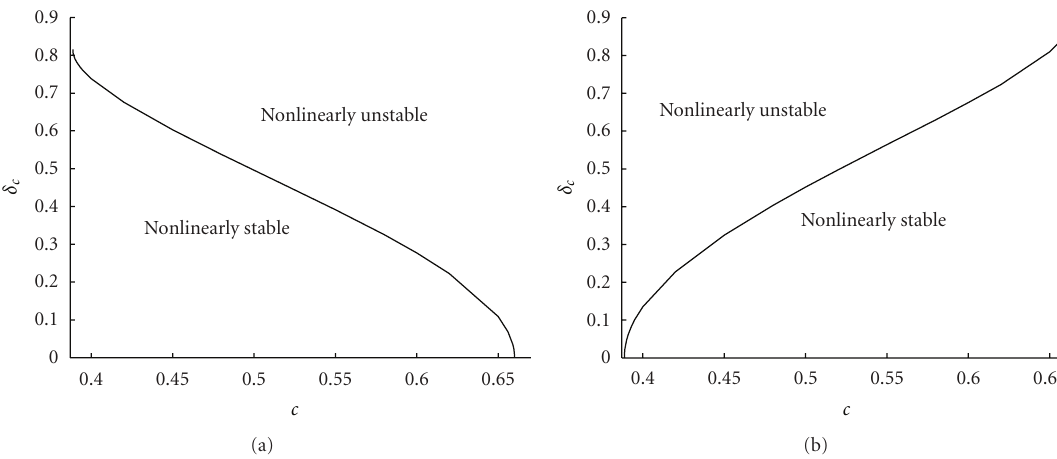
Figure 3: The critical value of δ c versus the parameter, the nutrient loading rate, c . (a) for OES; (b) for EES.